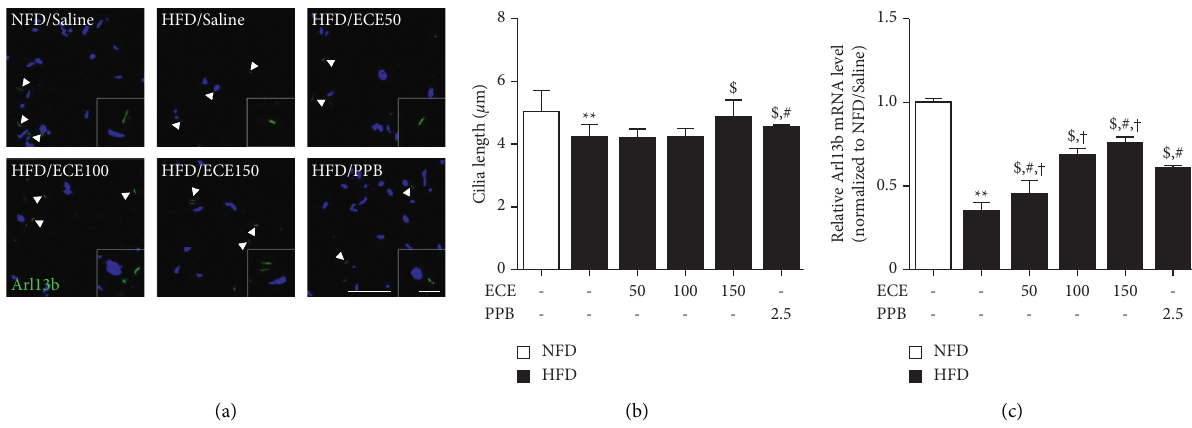
Figure 3: ECE and PPB restore the cilia length of visceral adipocytes in HFD animals. (a) The fluorescence images show Arl13b positive cilia (green) and nuclei (DAPI; blue) in the visceral adipocytes and (b) cilia length was measured by zen 2012 software (Zeiss microscopy image software). White arrows indicate cilia in the adipocyte and large magnification images show single cilia. Scale bar � 50 μ m. (c) The mRNA levels of Arl13b in visceral adipose tissue of HFD mice were measured by qRT-PCR. All data are shown as mean ± S.D. ∗∗ , p < 0 . 01, vs. NFD/ saline; $ p < 0 . 05, vs. HFD/saline; # p < 0 . 05, vs. HFD/ECE100; † p < 0 . 01, vs. HFD/PPB (Mann–Whitney U test). Arl13b, ADP-ribosylation factor-like protein 13B; ECE, Ecklonia cava extract; HFD, high-fat diet; NFD, normal fat diet; PPB, pyrogallol-phloroglucinol-6,